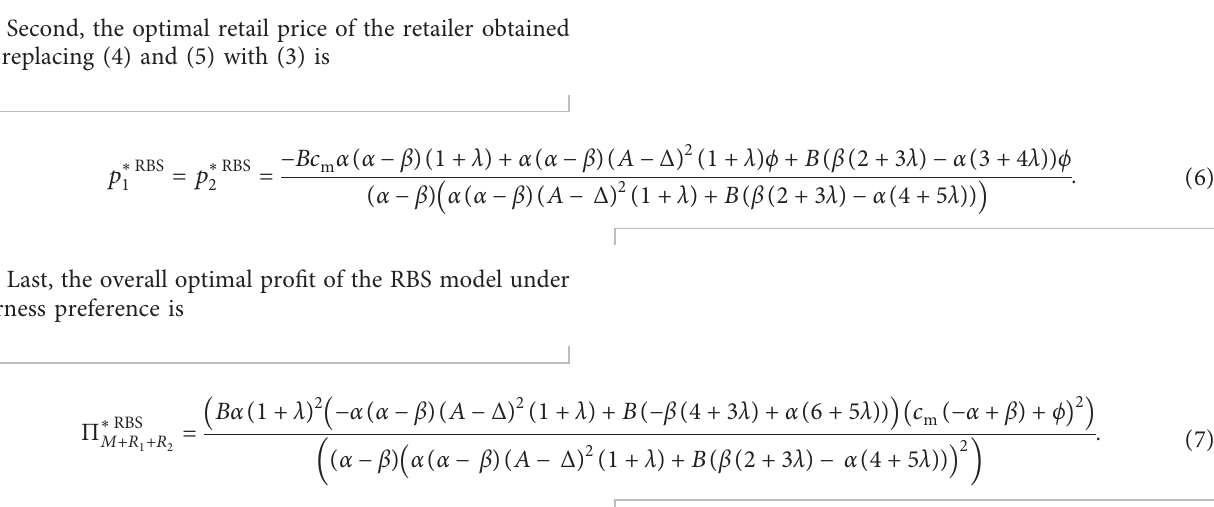
Figure 1: Different competitive cooperation game models. (a) RBS, (b) RCS, (c) RCR, (d) RBR, and (e)